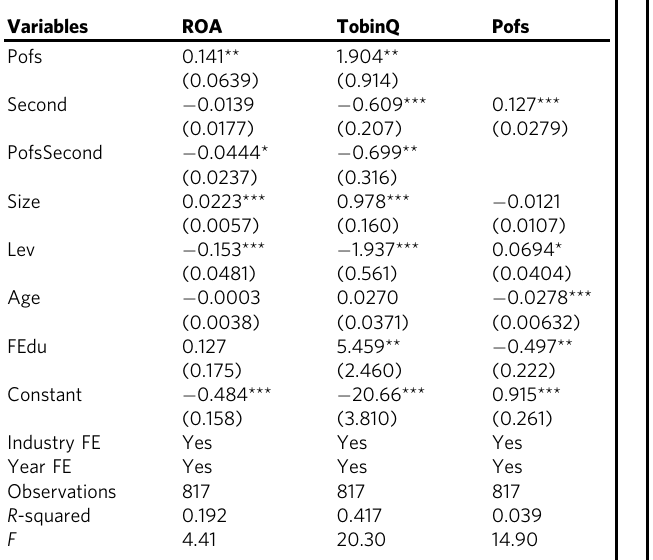
Table 7 Analysis of the in fl uence mechanism of female employment on enterprise performance.